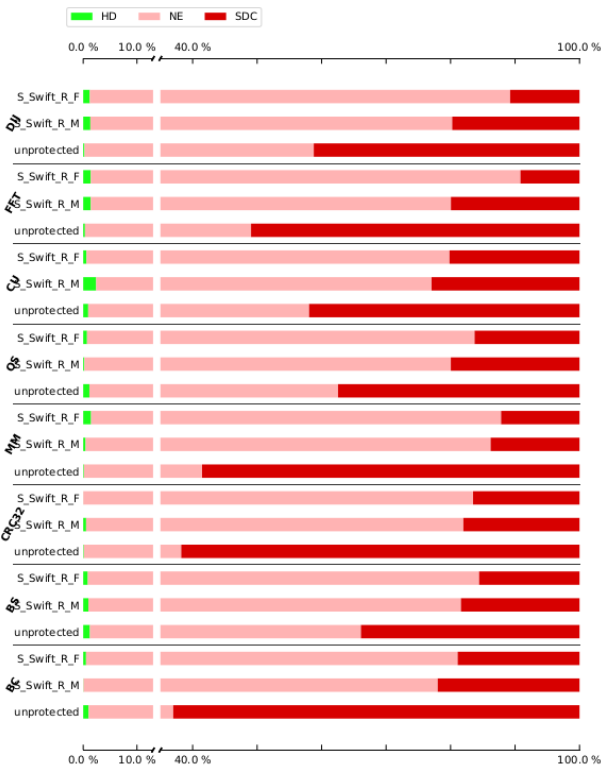
Figure A2. DFE fault injection results for 1 register.